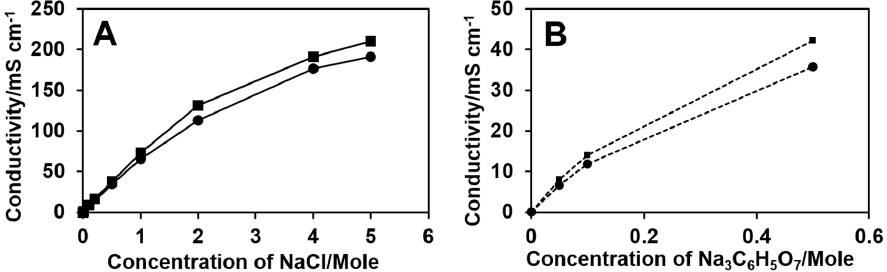
Figure 5. Electrical conductivity of PUL solutions 8% PUL ( ■ ) and 15% PUL ( ● ) with di ff erent NaCl ( A ) and Na 3 C6H 5 O 7 ( B ) content.